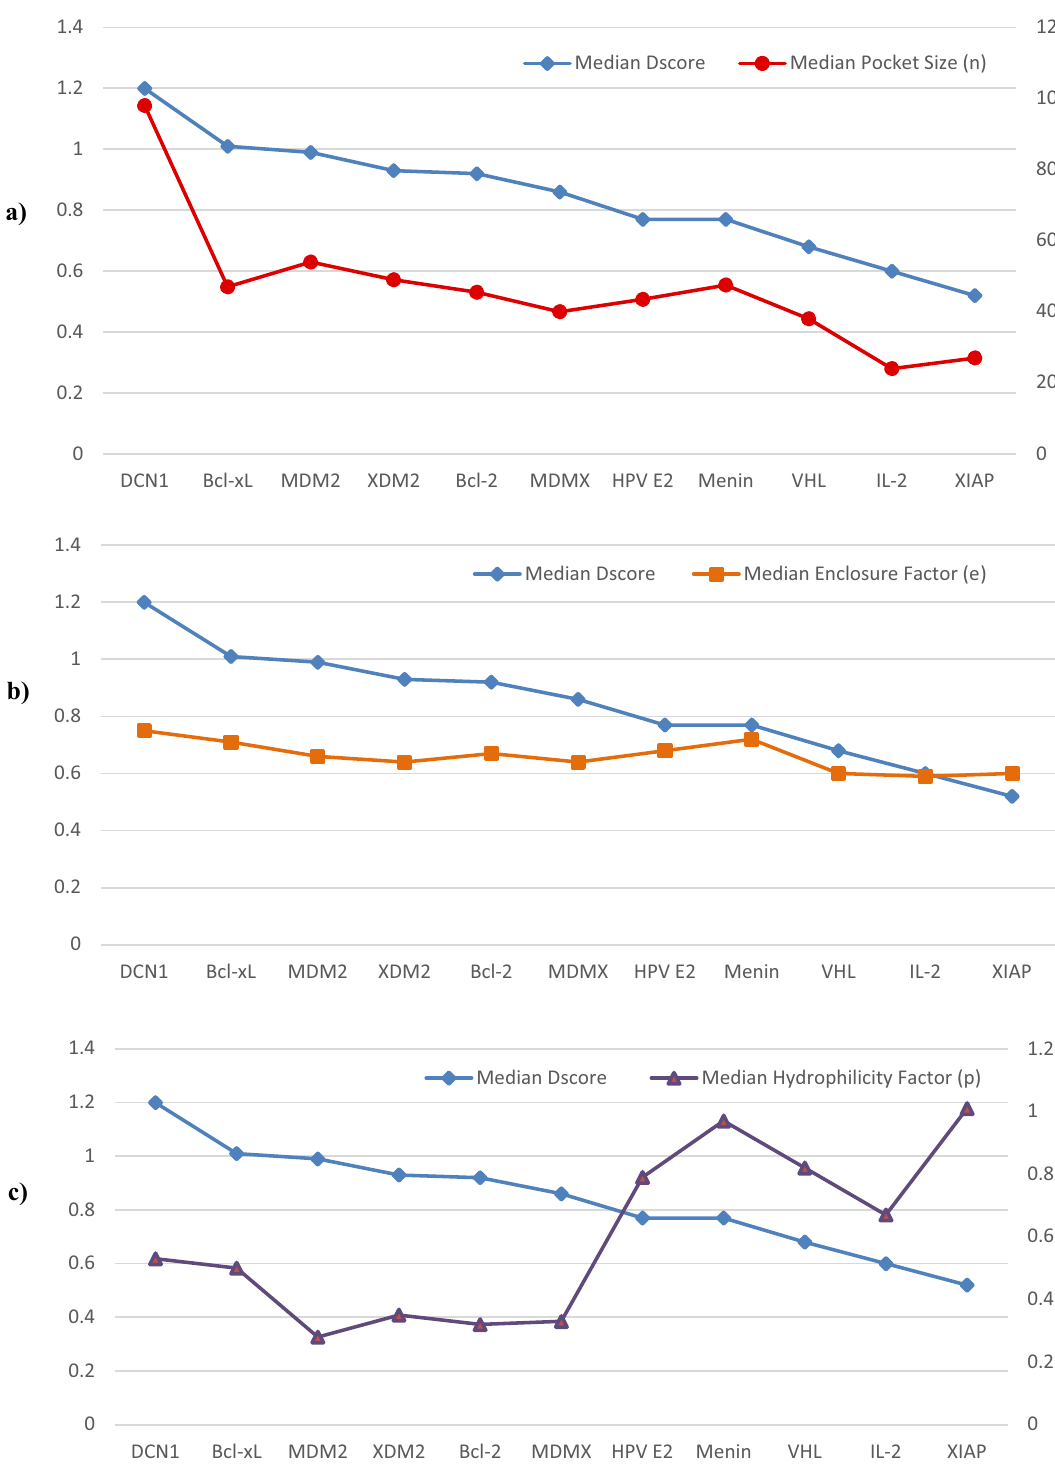
Figure 5. The correlation between the druggability of studied PPI and their ( a ) pocket size ( b ) enclosure and ( c ) hydrophilicity. ZipA values were undefined and hence assigned a value of